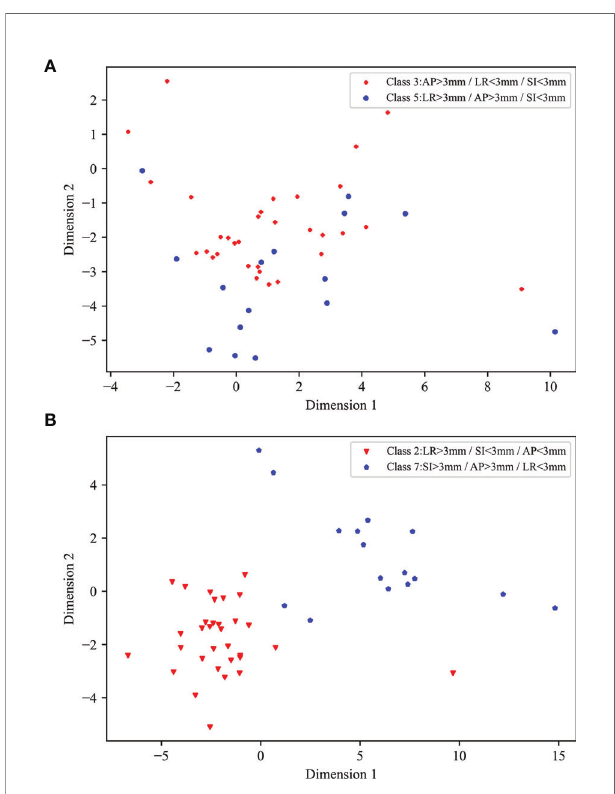
FIGURE 8 | Two-dimensional scatter plots of input data of ML 3 models following linear discriminant analysis dimensionality reduction: (A) scatter plot of third and fi fth classes, (B) scatter plot of second and seventh